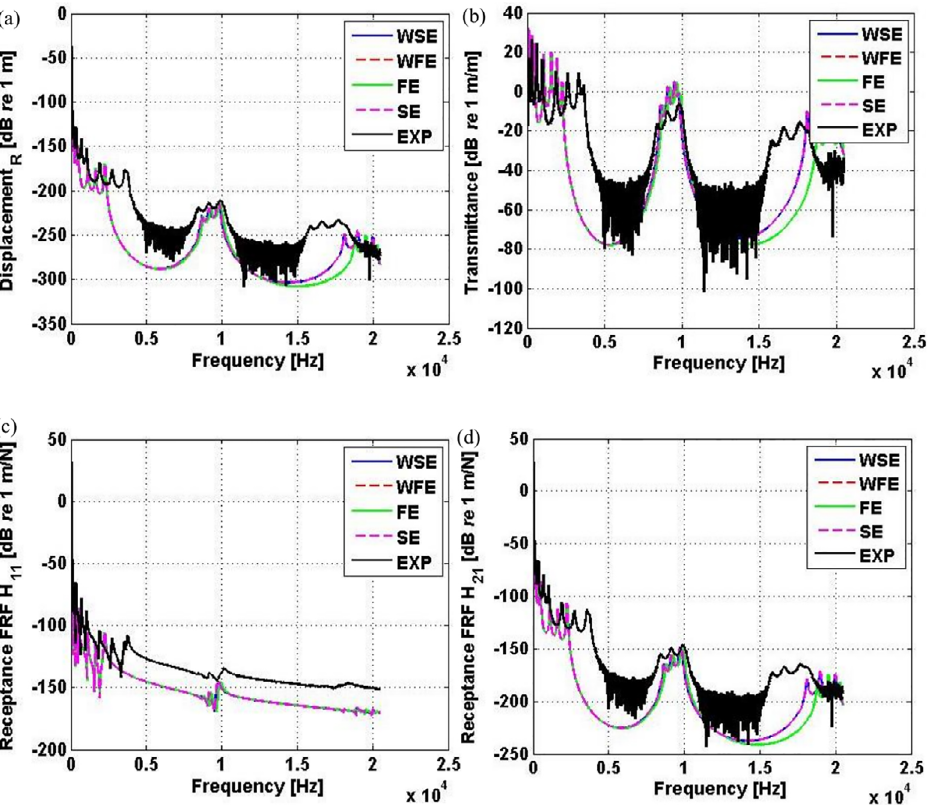
Figure 11. PC beam displacement of the right (a) side, transmittance (b), point receptance (c) and transfer receptance (d) calculated by the WSE, WFE, FE, SE methods and measured experimentally